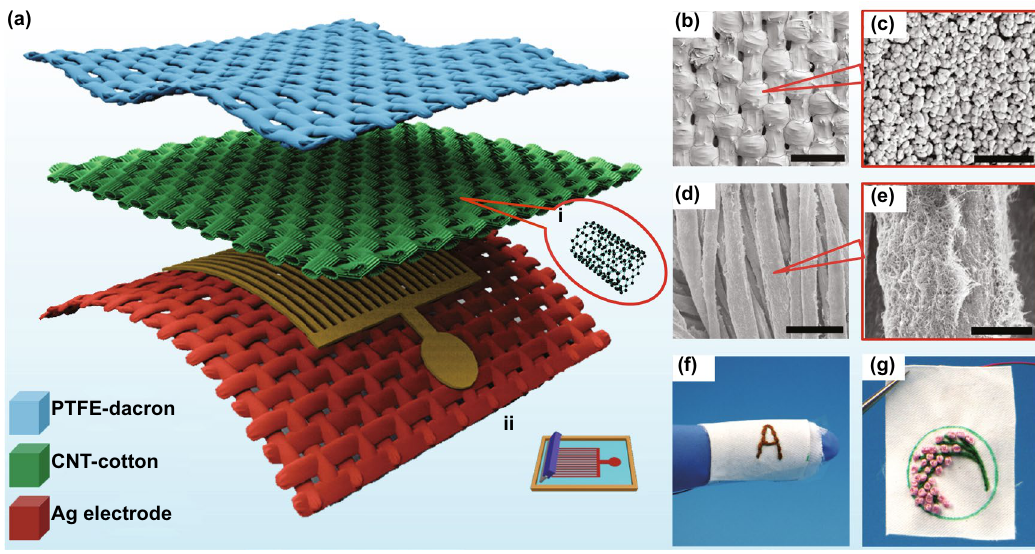
Fig. 1 Structural design of the F-TENG. a Schematic diagram of the F-TENG. The insets i and ii show the molecular structure diagram and screen-printing process diagram of CNTs, respectively. b‑e SEM images of the morphology of PTFE and CNT coated on the fabric at different magnification. The scale bars are 300 µm for ( b ), 1 µm for ( c ), 20 µm for ( d ), and 5 µm for ( e ). f , g Photographs showing that the F-TENG is under finger bending ( f ), or the form of embroidery ( g